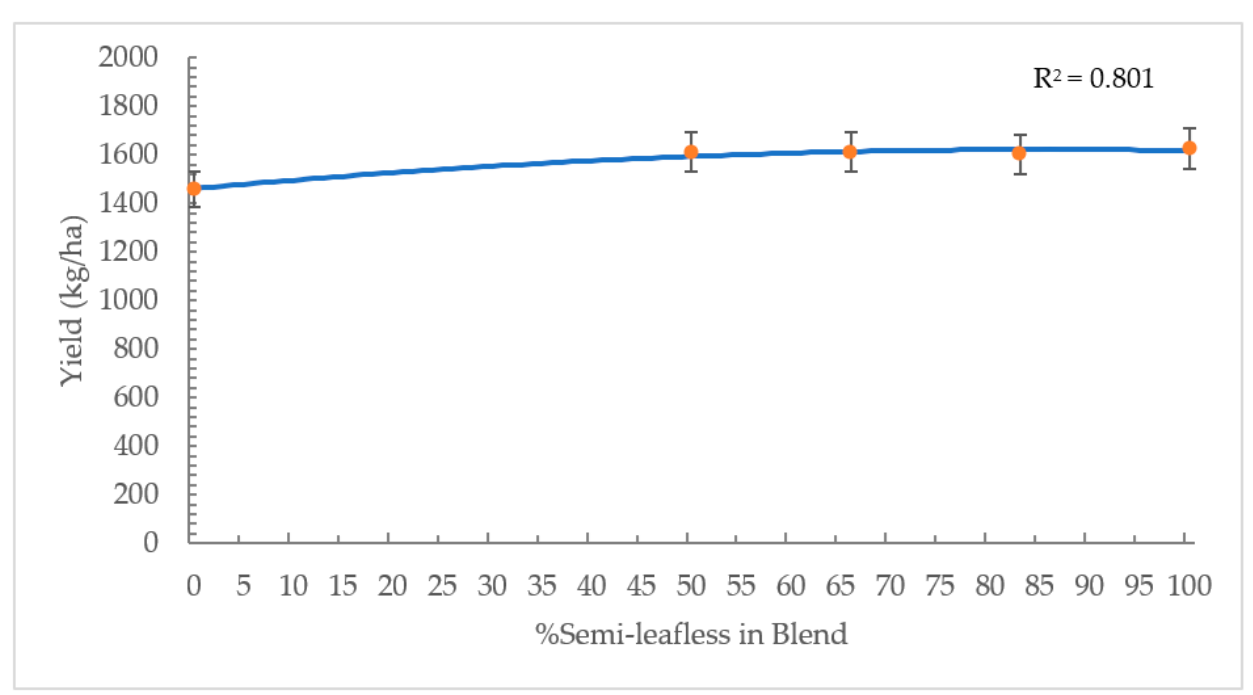
Figure 7. Interaction of variety and leaf-type mixing ratios on yield (kg ha − 1 ). Mean of five site-years, one in 2017, two in 2018, and two in 2019. Columns with different letters (a–h) representing the mean of yield were significantly different in LSD 0.05 . The error bar represents the positive standard error in LSD 0.05 . Treatments were listed as semi-leafless + leafed pea, 0/100 is leafed monoculture, for CDC Amarillo (Amarillo), CDC Centennial (Centennial), CDC Dakota (Dakota), and CDC Striker (Striker).